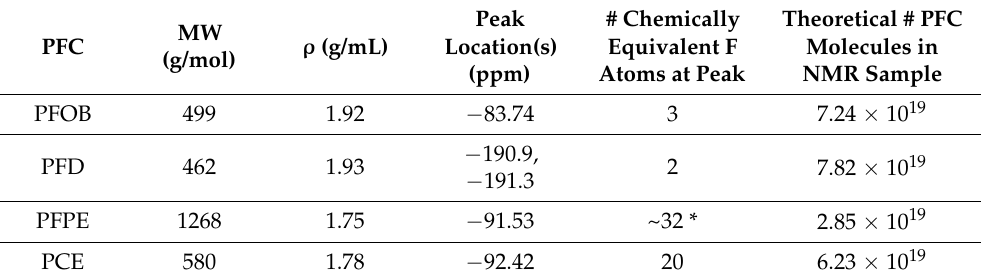
Table 1. Summary of perfluorocarbon properties used to calculate the theoretical number of per- fluorocarbon molecules that should be present in an NMR sample if the nanoemulsion was 100% perfluorocarbon loading PFCs tested are: perfluorooctyl bromide (PFOB), perfluorodecalin (PFD), perfluoro(polyethylene glycol dimethyl ether) oxide (PFPE), and perfluoro-15-crown-5-ether (PCE). * The resonant peak at − 91.53 ppm corresponds to a CF2 group in the monomer repeating portion of the PFPE molecule. The chain length is variable, so the number of 32 chemically equivalent atoms is an estimate